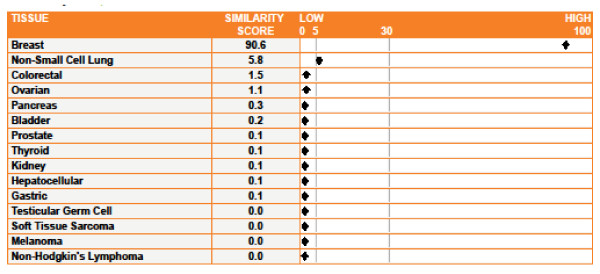
Sample Tissue of Origin Test Report. The Tissue of Origin Test report for specimen with case ID K in this study is shown as a sample report. The report presents similarity scores to each of the 15 tissue types included in the Tissue of Origin Test panel. A similarity score of 90.6 indicates a high confidence that this specimen is a breast cancer metastasis to the brain. Also, the Tissue of Origin Test excluded 13 tissue types (those with similarity scores less than or equal to 5) as the likely tissue origins for this specimen.